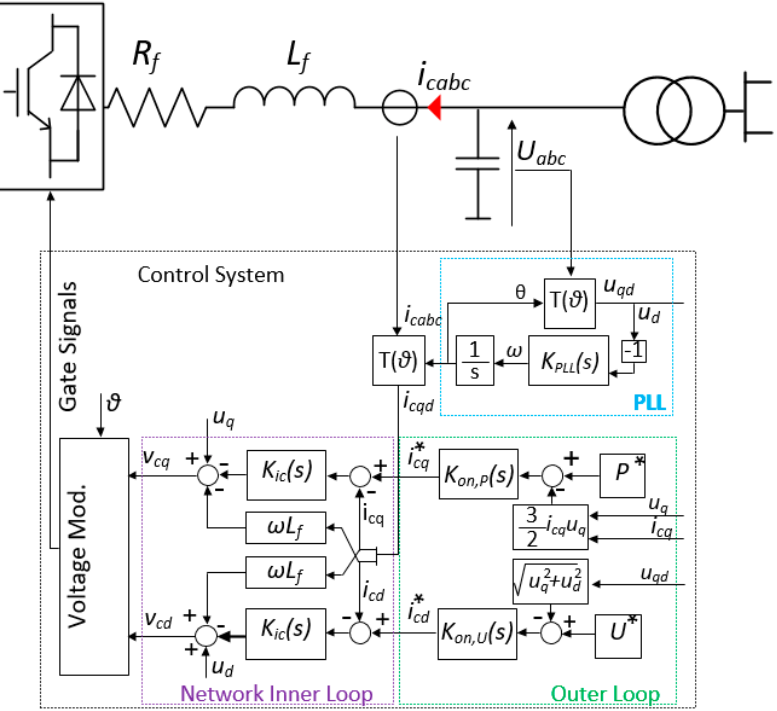
Figure 3. Power voltage current control (PVCC) controller diagram. PLL: Phase ‐ Locked Loop